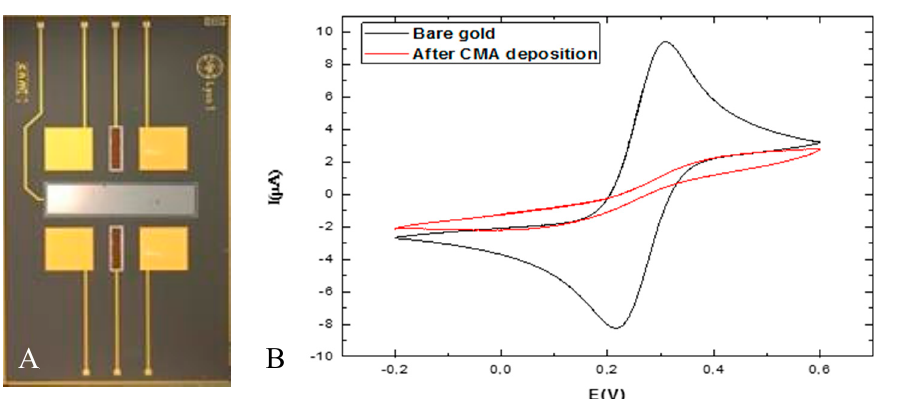
Figure 1. ( A ) Biosensor platform containing four gold WE, reference electrode (RE) based on Ag/AgCl and counter electrode (CE) based on platinum ( B ) Cyclic voltammograms of gold WE before (black) and after (red) CMA